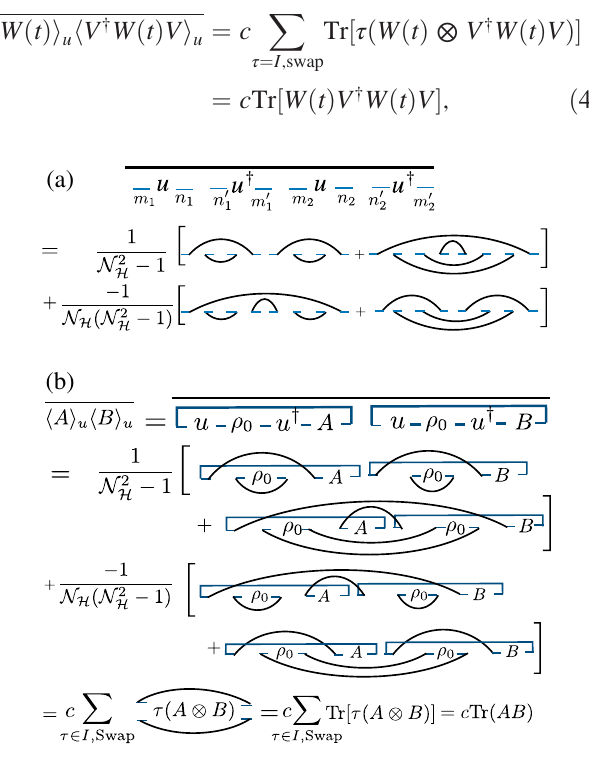
FIG. 2. Identities for our protocol with global unitaries . (a) Diagrammatic representation of the 2-design identities of the CUE Eq. (3). (b) Correlations between two measurements with A ¼ W ð t Þ , B ¼ V † W ð t Þ V . Here, we have introduced the notation for the initial pure density matrix ρ 0 ¼ j k 0 ih k 0 j